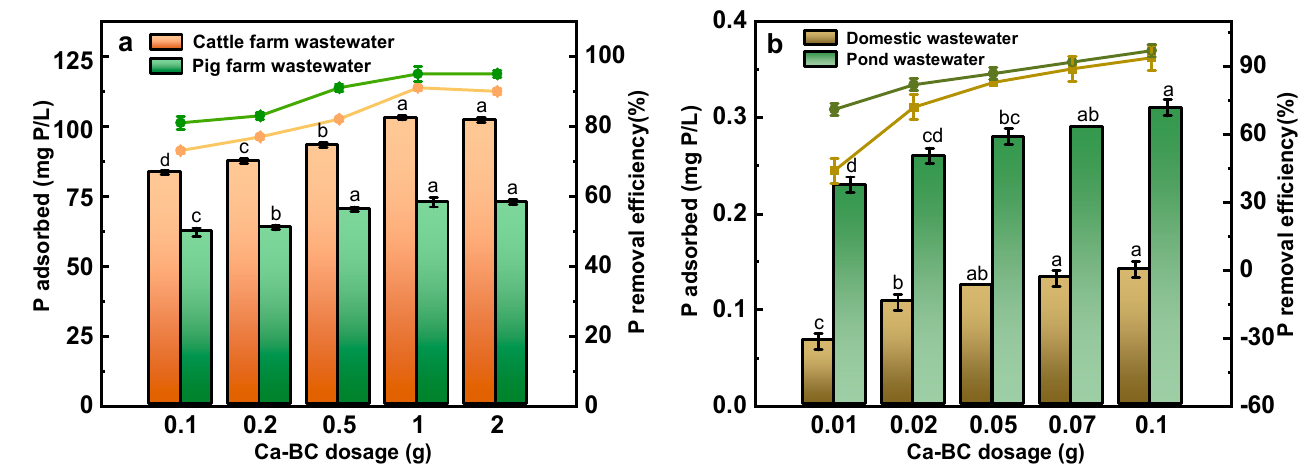
Figure 4. Adsorption and removal of phosphorus from cattle farm and pig farm wastewaters by Ca-BC. ( a ) Adsorption and removal of phosphorus from domestic and pond wastewaters by Ca-BC. ( b ). The letters a, b, c, d represent the results of significance analysis of variance.